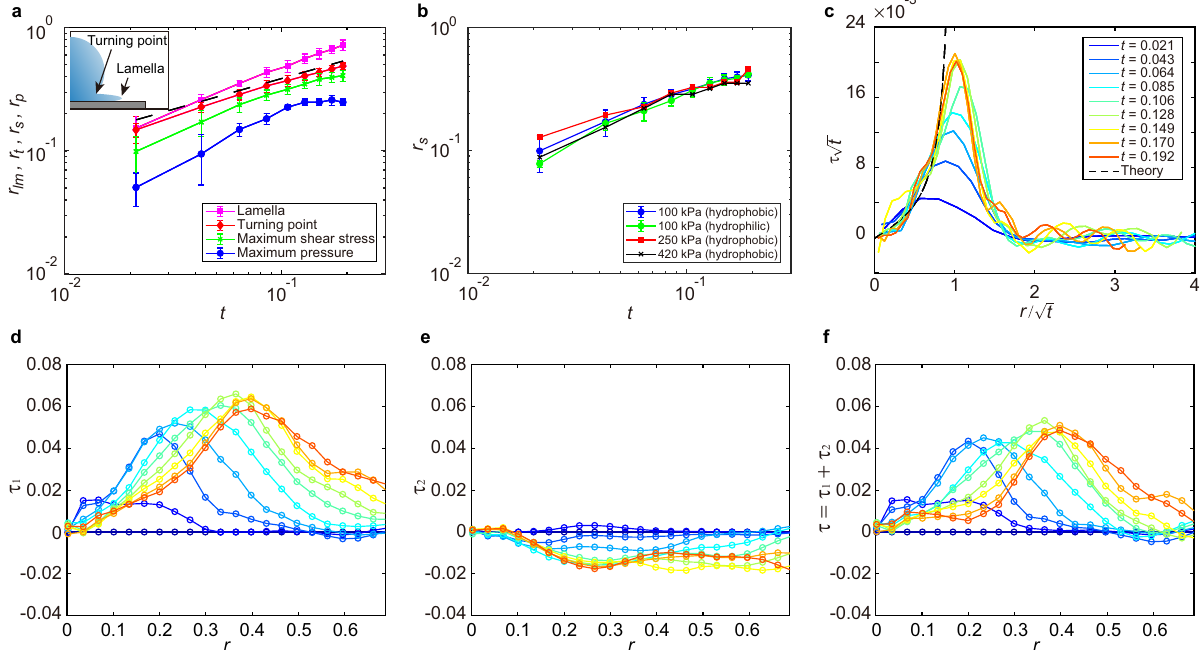
ffiffiffiffiffi p = 2. Upper inset: De fi nition of the kinematic features of an impacting drop. b The 6 t ffiffi p ffiffi p t t as a function of the rescaled radial position r = . The dashed line is the